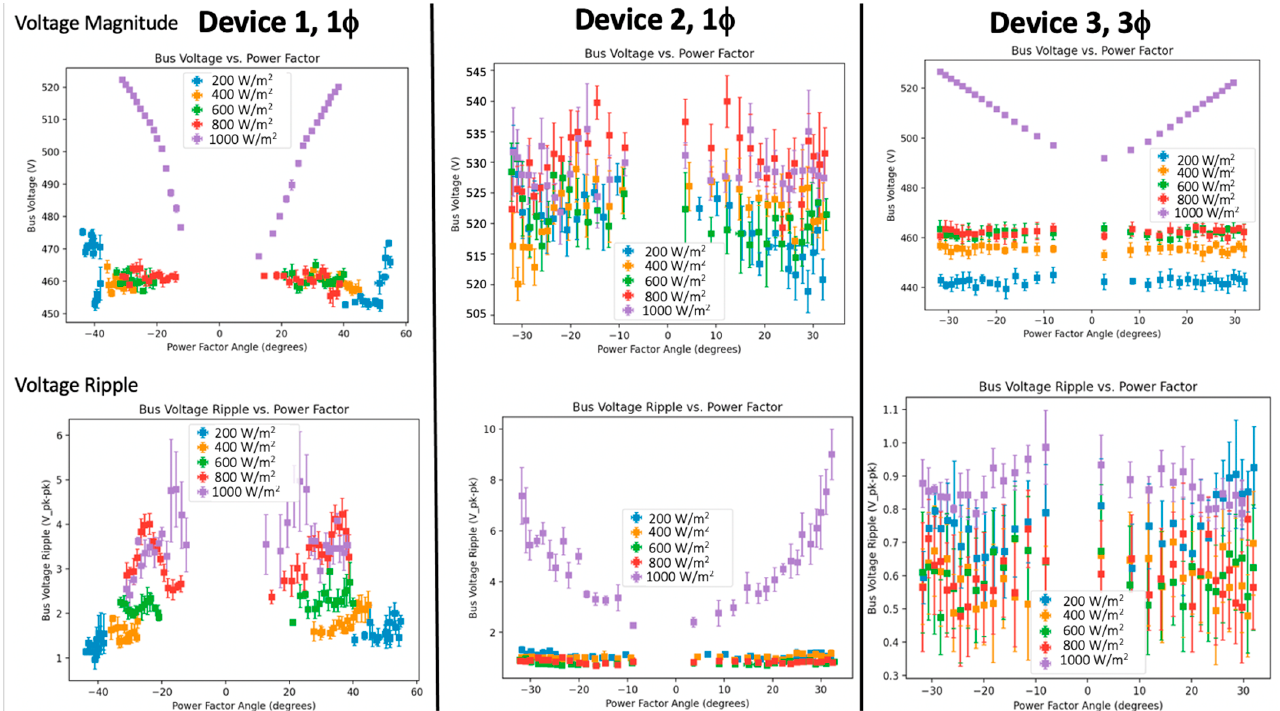
Figure 10. DC Bus voltage magnitude ( top ) and voltage ripple ( bottom ) measurements for different power factors and irradiance levels for Inverter A single-phase inverter ( left ), and Inverter B single- phase inverter ( middle ) and Inverter B three-phase inverter ( right ).